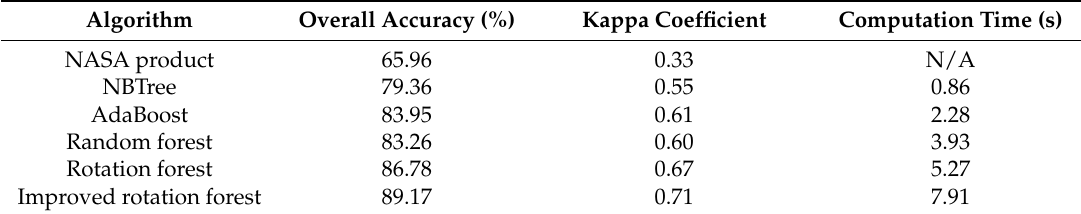
Table 7. Comparison of accuracy and computation time for each algorithm.